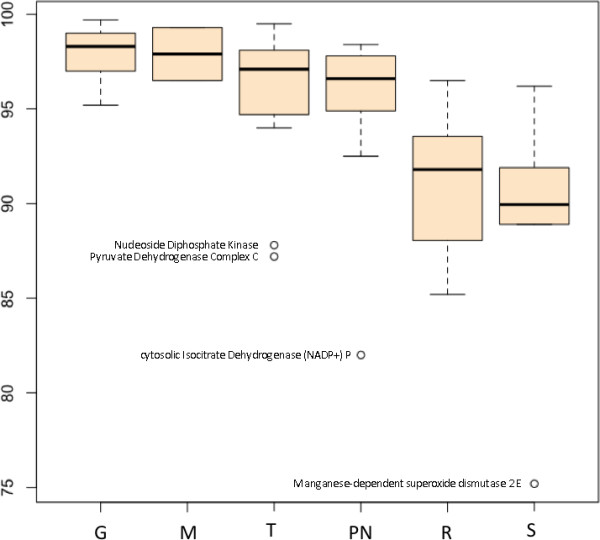
Effect of sub-pathway membership on sequence divergence of GSIS proteins. Tukey's boxplot of the results of ANOVA analysis on the effect of sub-pathway membership on sequence divergence of GSIS proteins. G = glycolysis, M = metabolite transport, R = respiratory chain, S = glutathione pathway, TPN = TCA cycle+pyruvate cycle+NADH shuttle.